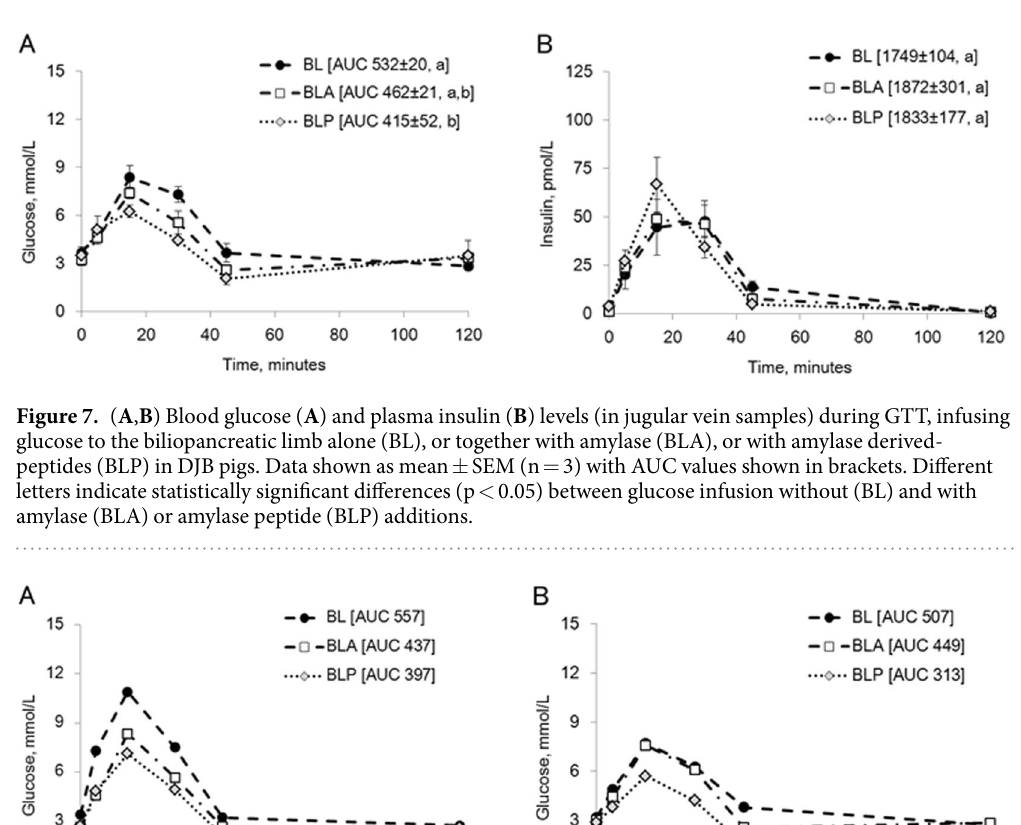
® ) reduced plasma glucose levels, and the AUC for glucose, after an oral glucose load (Fig. 3A) as well as after a test meal (Fig. 4A). In contrast, slower elimination and increased glucose AUC was seen after Creon ®